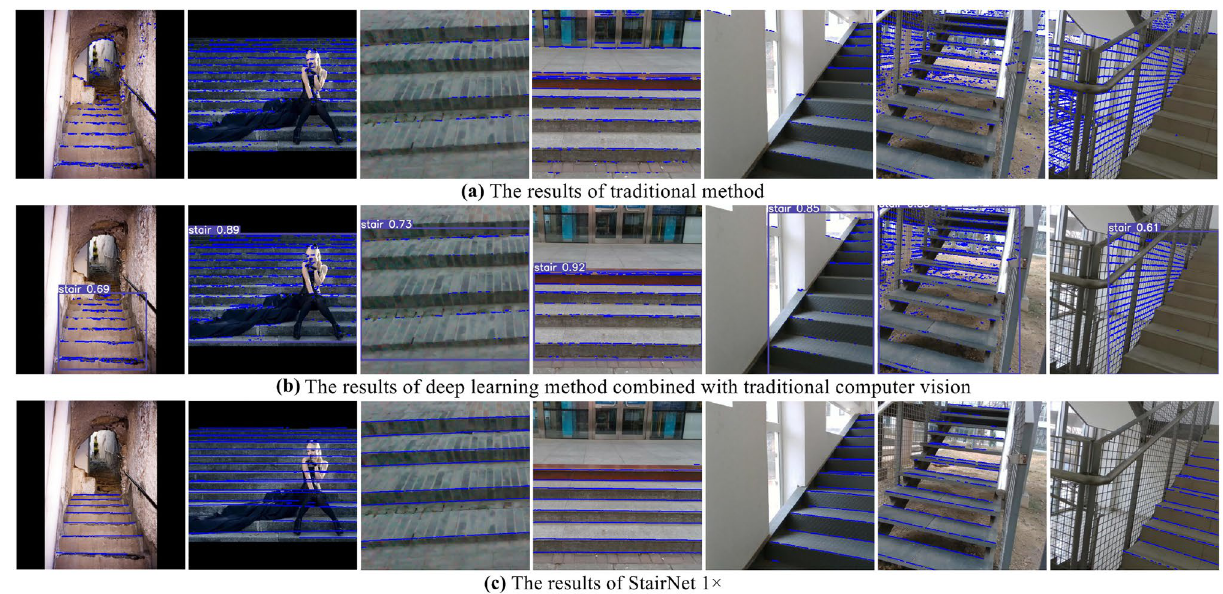
Figure 8. Partial visualization results produced by traditional method, deep learning method combined with traditional computer vision and StairNet 1 × on the validation set. Our StairNet performs much better